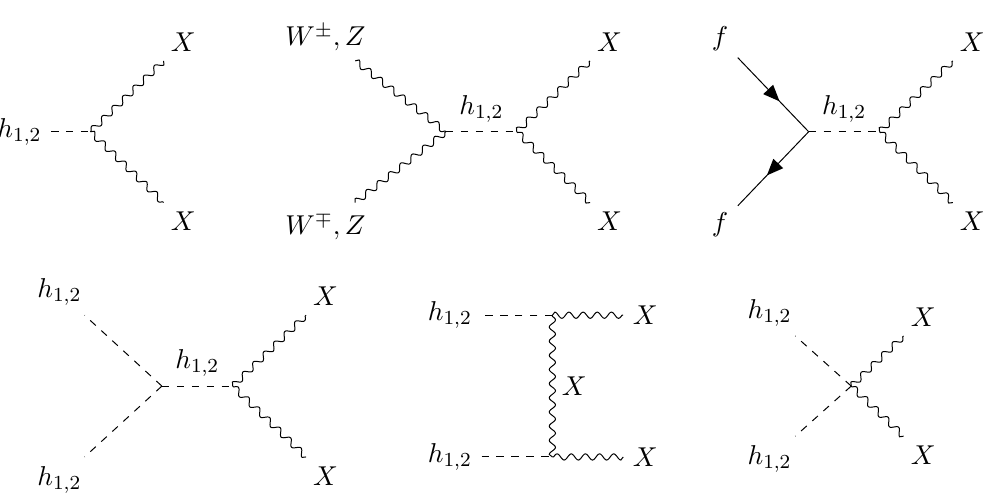
Figure 15 . Feynman diagrams showing non-thermal production channels of X aEWSB.